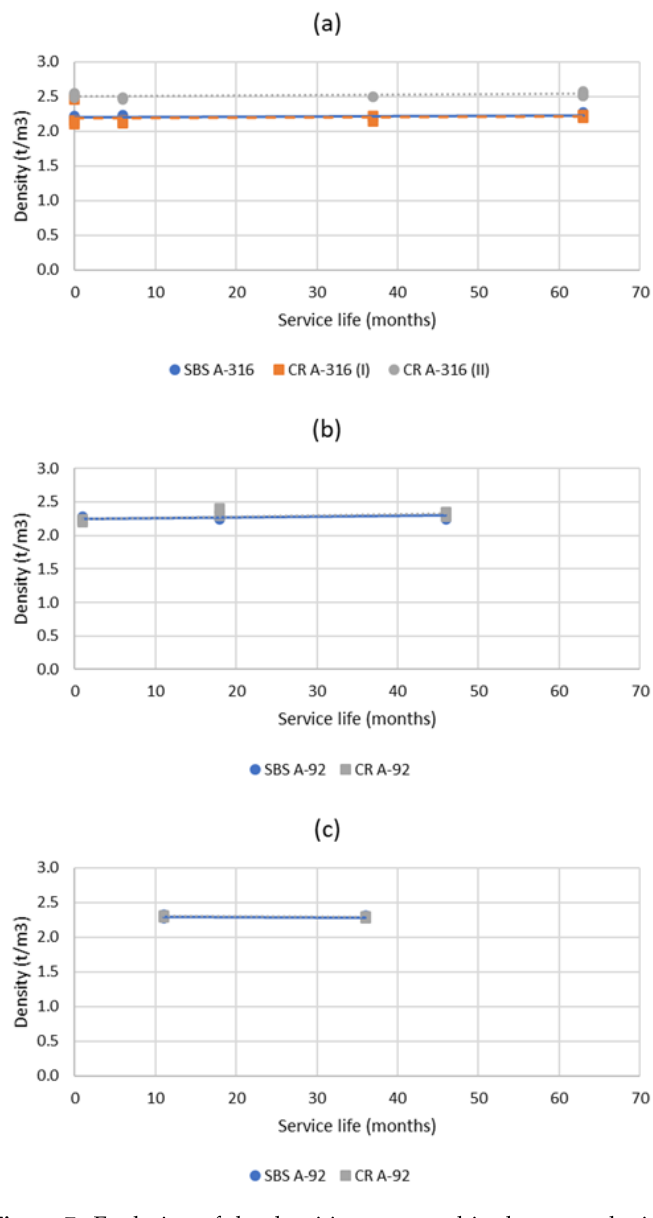
Figure 7. Evolution of the densities measured in the cores obtained along the service life of the highway sections studied: ( a ) A-316; ( b ) A-92-I; ( c ) A-92-II.